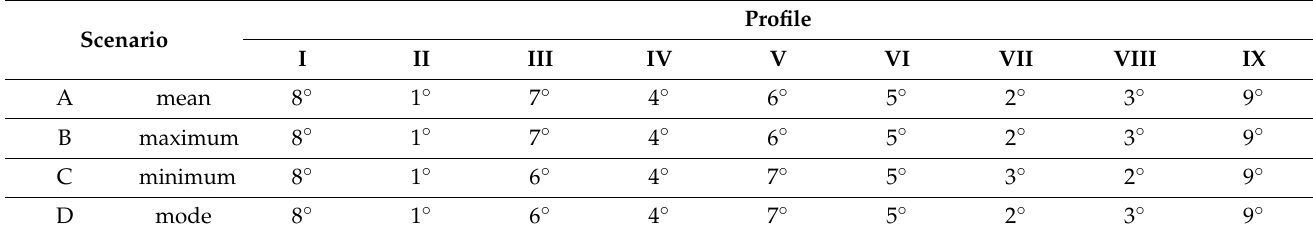
Table 6. Hierarchy of potential users obtained through application of the CGT multi-criteria